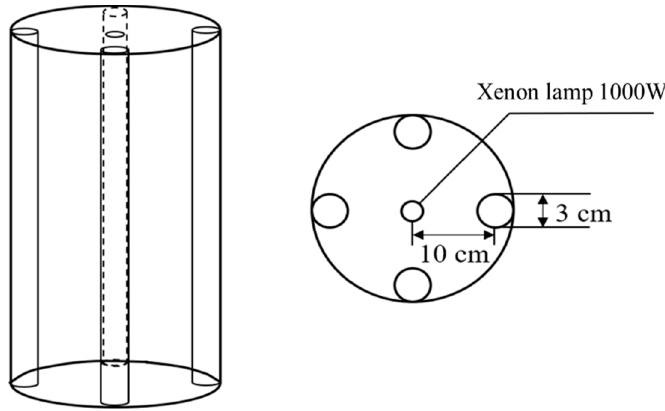
Figure 1. The device for simulating visible light catalytic degradation of DCF in sewage.